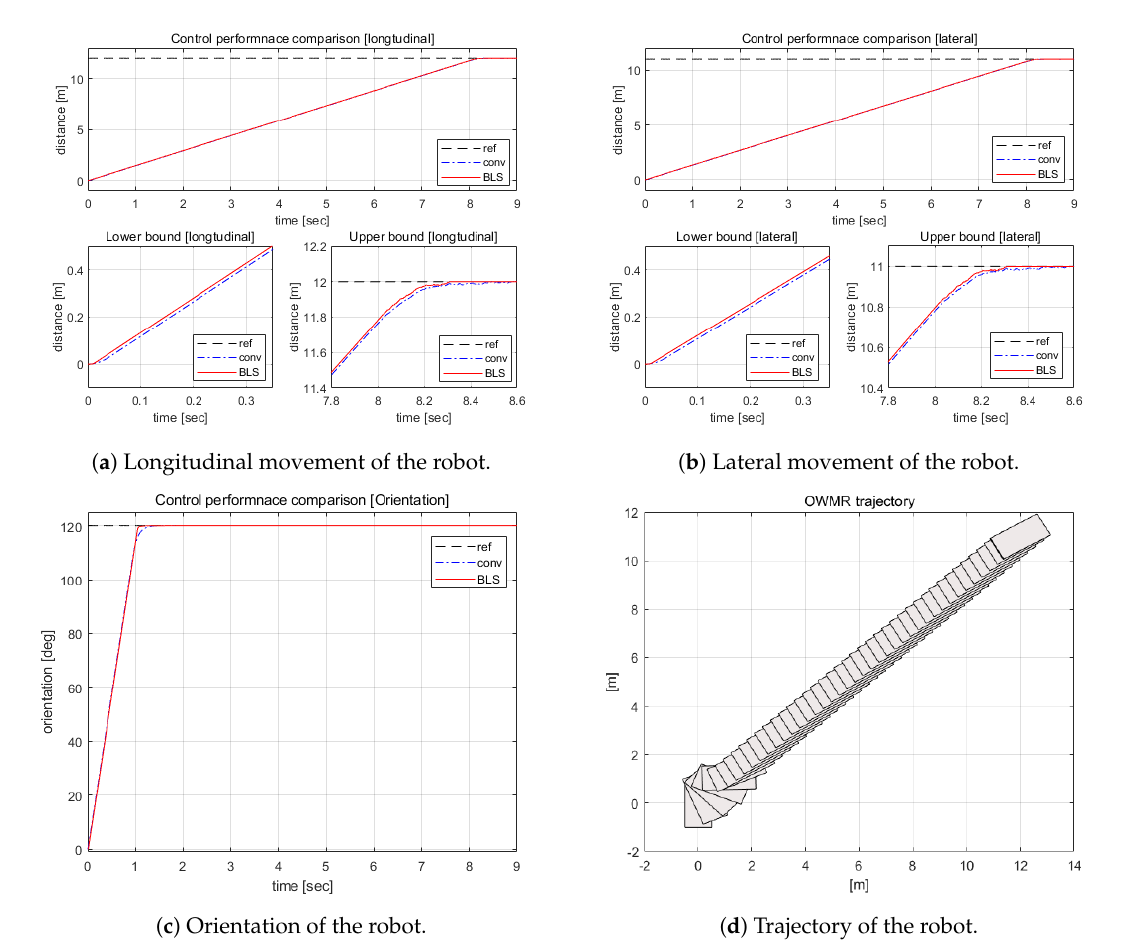
Figure 8. Point-to-point movement of the